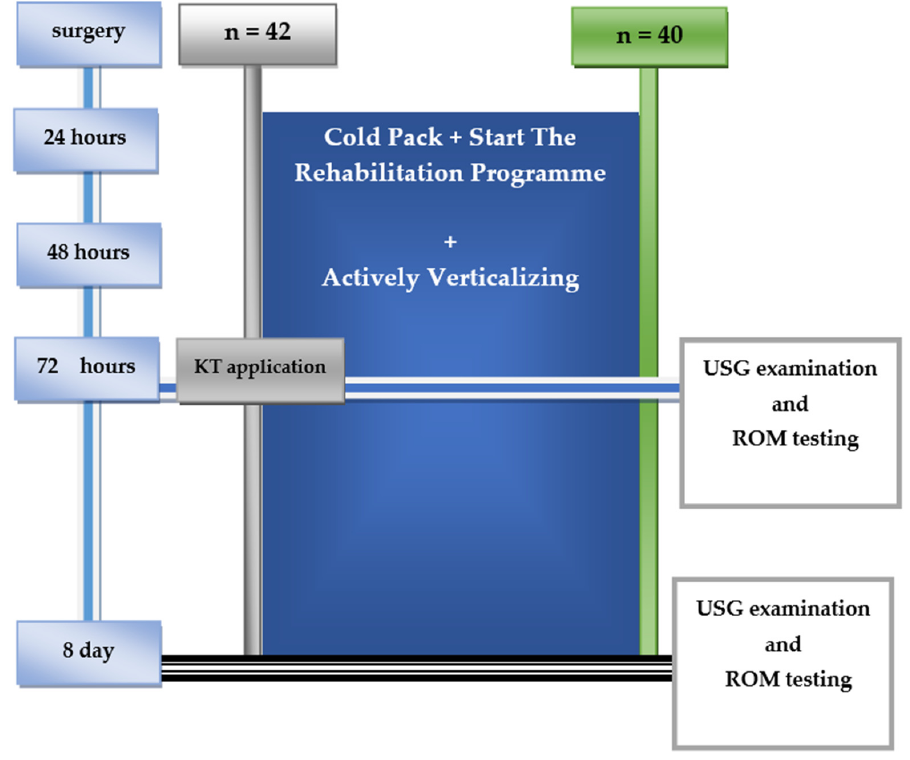
Figure 1. Demonstration of the conduct of a time-divided experiment. ROM—range of motion; KT—Kinesio Taping; USG—ultrasound. KT—Kinesio Taping;